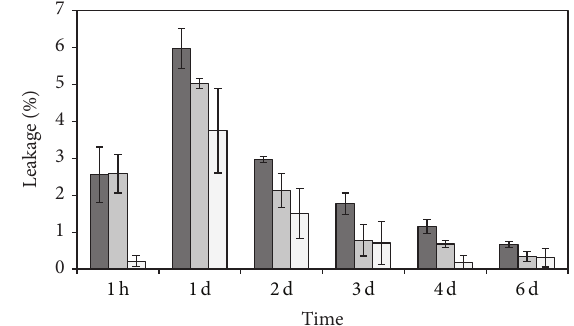
Figure 2: Three sets of CPO sol-gel beads with CPO concentrations of 40 𝜇 g/mL (dark grey bars), 8 𝜇 g/mL (grey bars), and 4 𝜇 g/mL (light grey bars) were aged for one week. The storage buffer was replaced in the time intervals indicated on the graph and tested for CPO leakage. Each set was replicated three times and contained three beads per sample tube. The specific activity of the reference sample with free CPO in solution was 1436±39 IU/mg. The column heights represent the mean value and the error bars represent ± one standard